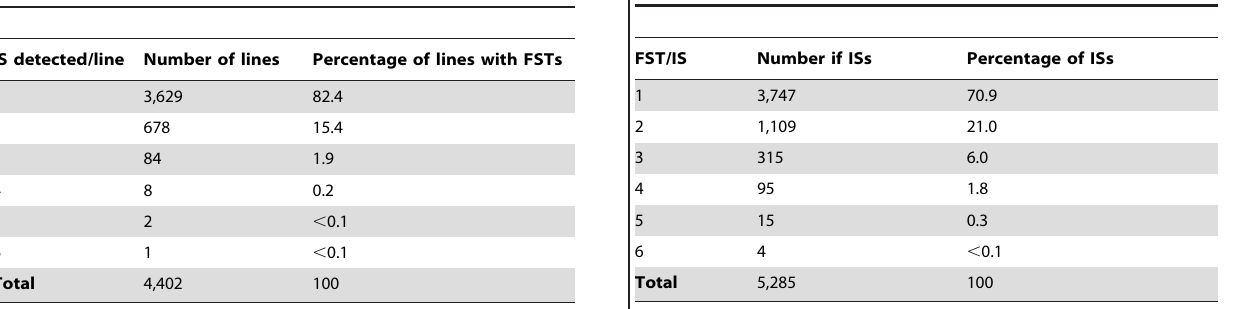
Table 5. Number of T-DNA integration events detected per line. Table 6. Number of FSTs supporting individual